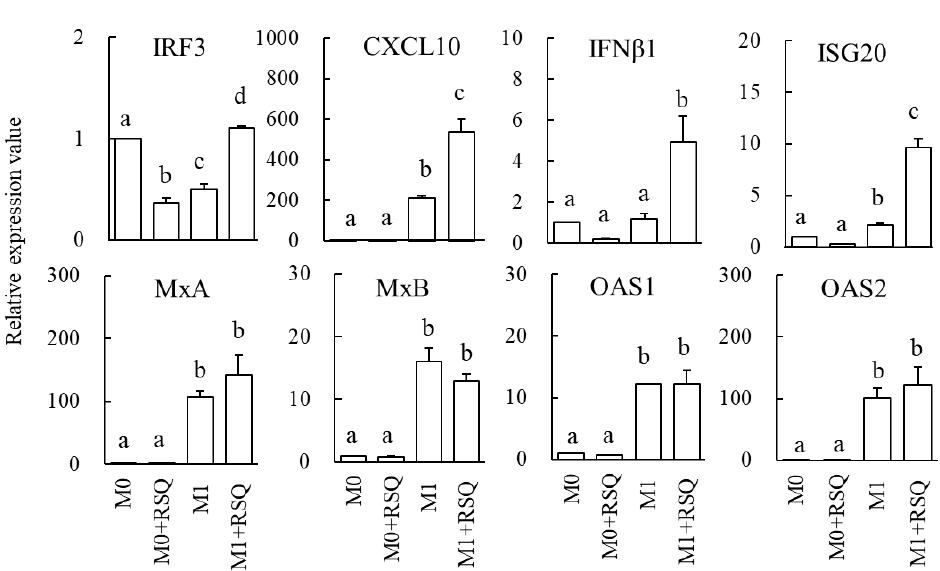
Figure 3. Effects of resiquimod (RSQ) on the expression of antiviral factor genes in M1-phenotype macrophages. M1-phenotype macrophages were cultivated in the presence of RSQ (0 – 10 μg/mL) for 3 h. Quantitative real-time reverse transcription polymerase chain reaction assessed the relative ex- pression values. The data are presented as the mean and SD ( n = 3). The comparison among multiple groups was evaluated using Dunnett’s posttest following ANOVA. * p < 0.05 ( vs. 0 μg/mL RSQ).